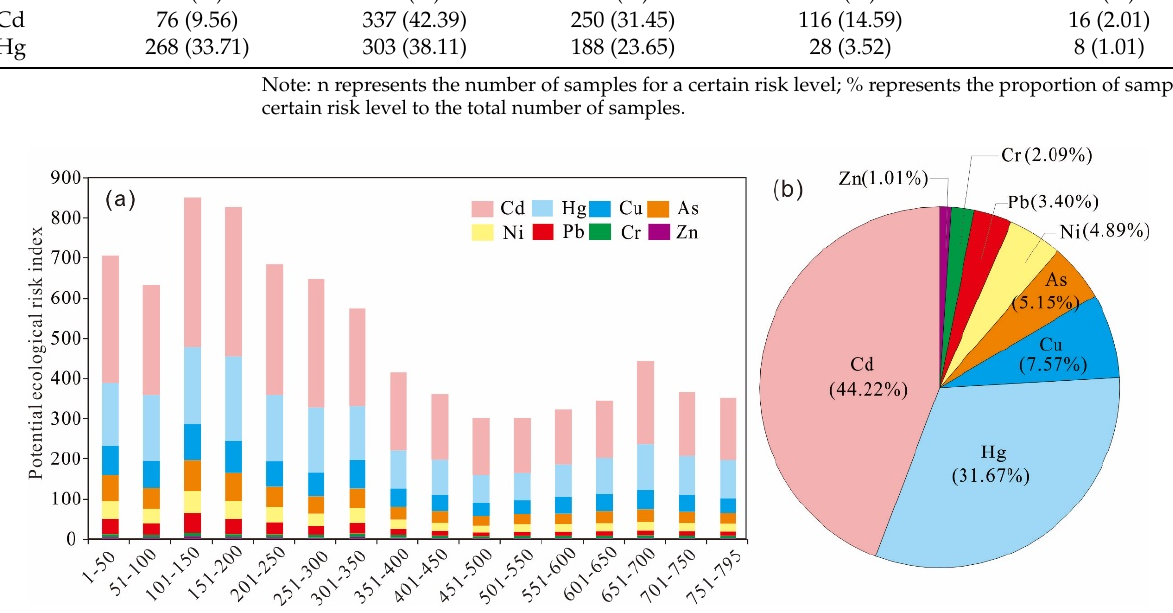
Figure 5. Total potential ecological risk assessment of HMs in the sampling sites ( a ), and the contribution of HMs to potential ecological risks ( b ).